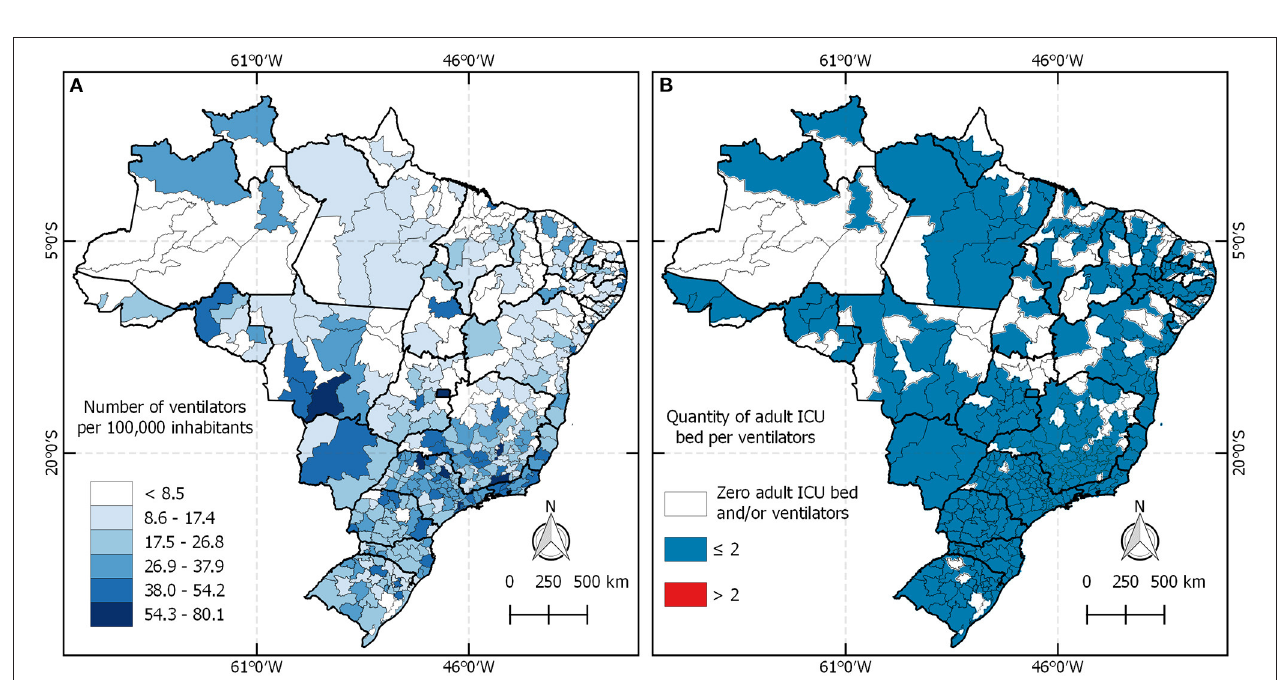
FIGURE 5 | (A) Distribution of ventilators in Brazil for every 10,000 inhabitants. (B) Ventilators per bed according to ANVISA.